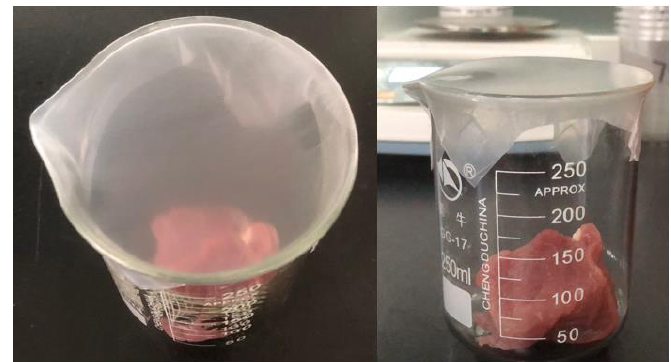
Figure 1. Photo of a pork sample.